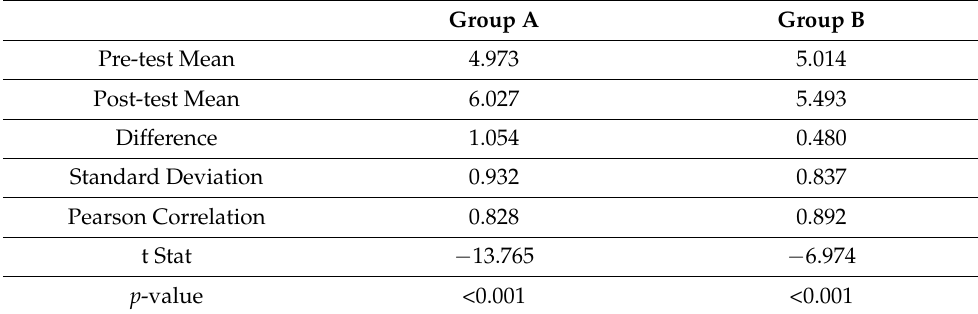
Table 7. t -test results of pre-test and